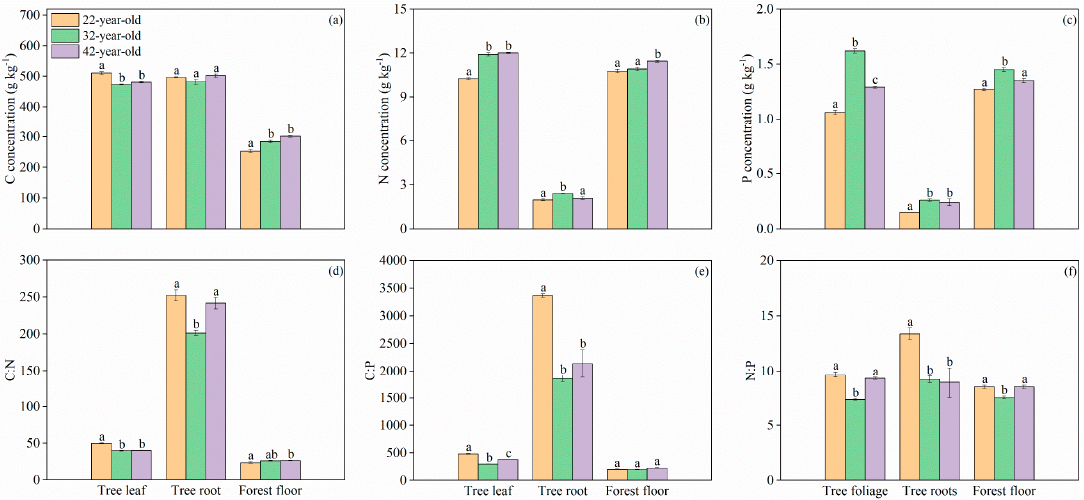
Figure 4. ( a ) C concentration, ( b ) N concentration, ( c ) P concentration, ( d ) C:N, ( e ) C:P and ( f ) N:P in